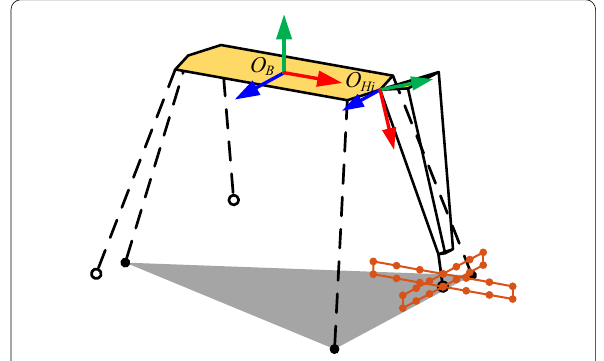
Figure 14 Validation configurations of a leg